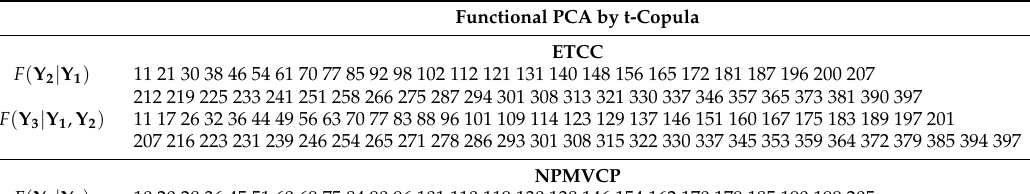
Table 9. Change point detection by ETCC and NPMVCP of FPCA and copulas with simulated multivariate